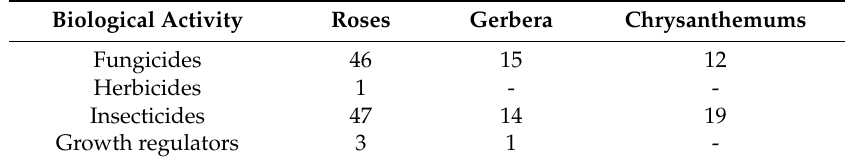
Table 5. Number of active substances found in the 90 samples according to their biological activity.